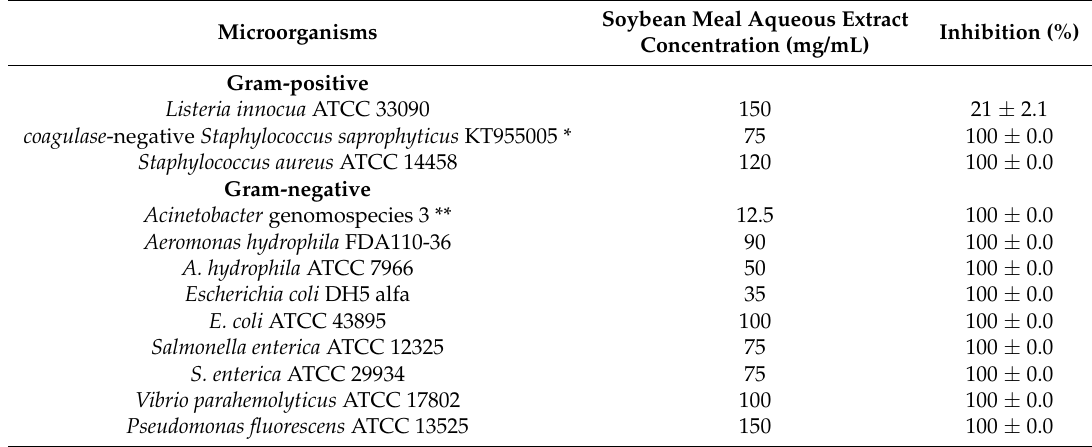
Table 3. Minimal inhibitory concentration of the aqueous extract from soybean meal. Microorganisms